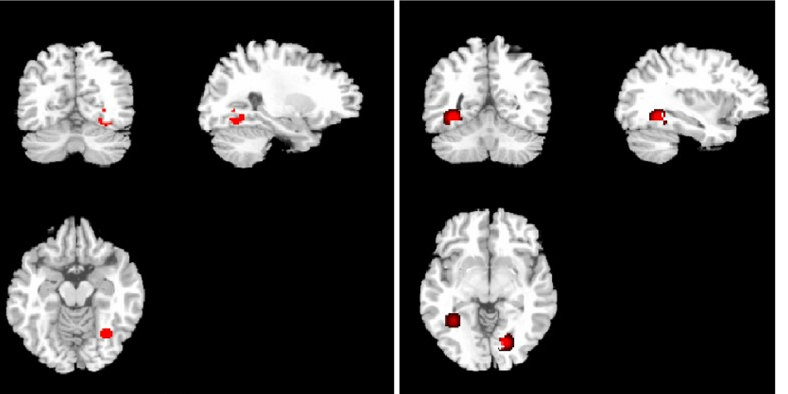
Figure 2. Brain FA map derived from the region of interest analysis: (a) optic nerve, (b) optic radiation. We set the full width half maximum (FWHM) as